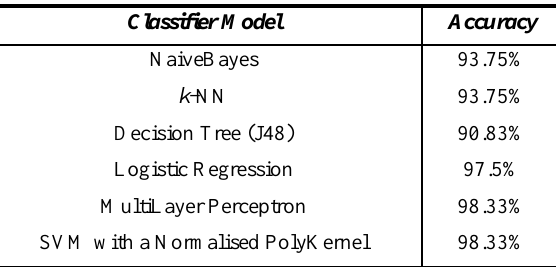
Table 2: Comparison of performance for